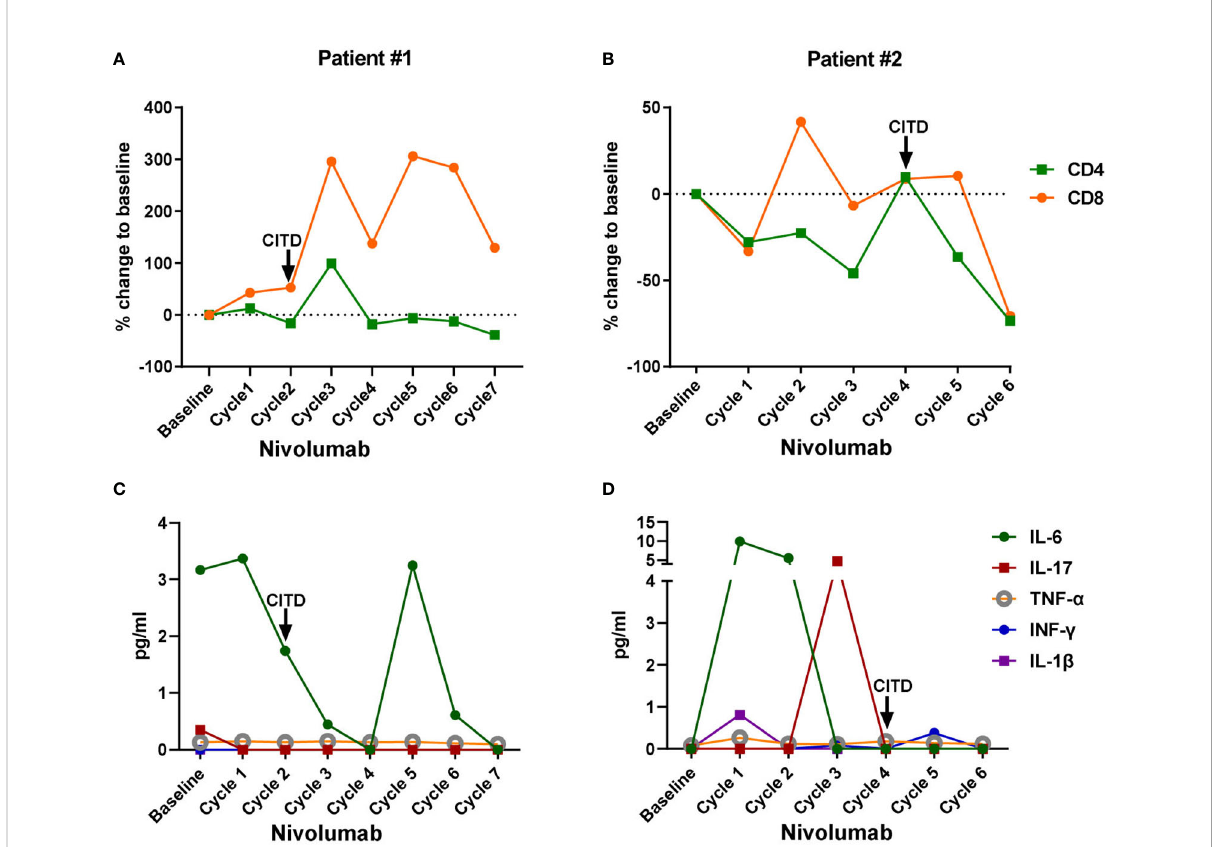
FIGURE 2 Dynamic changes of peripheral blood CD4 + T cells, CD8 + T cells, and in fl ammatory cytokines in the lung cancer patients treated with Nivolumab. Blood samples were collected at the baseline and after each cycle of Nivolumab treatment during the biomarker trial. Baseline: values from the blood samples collected before the Nivolumab treatment initiation; Cycle 1: values after the 1 st dose of Nivolumab, from the blood samples collected right before the second dose administration; Cycle 2: values after the 2 nd dose of Nivolumab, from the blood samples collected right before the third dose administration, and so on. (A, B) Percent change of peripheral CD4 + T cells and CD8 + T cells from baseline after each dose of Nivolumab in patient #1 and #2, respectively. (C, D) Plasma IL-6, IL-17, TNF- a , INF- g , and IL-1 b levels in patient #1 and #2, respectively. Onset of checkpoint inhibitor-induced thyroid dysfunction (CITD) is indicated by arrows on the